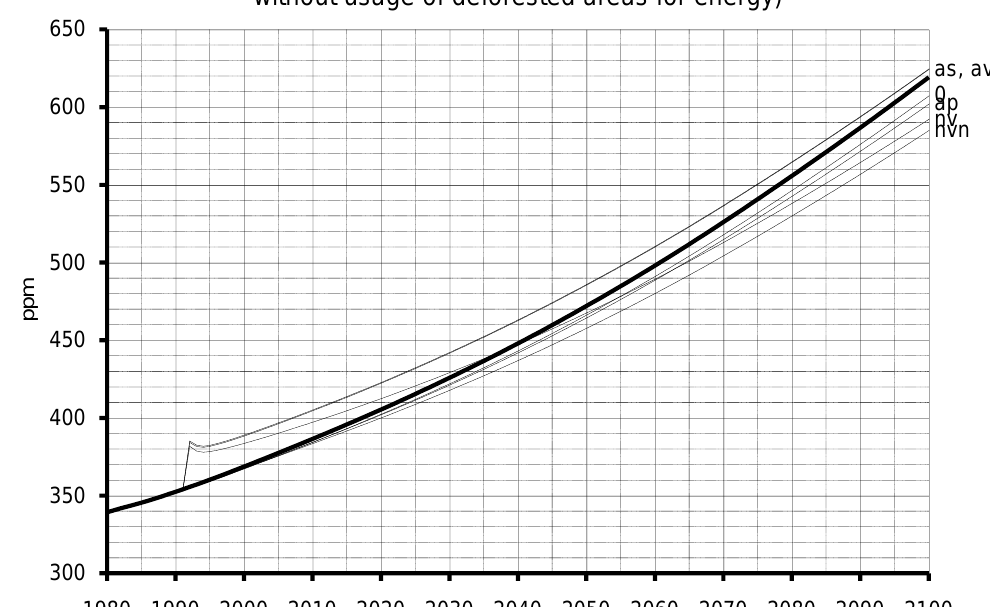
Figure 8. In a “+1%/a” CO 2 emission growth scenario, when dedicating 10% of areas for biomass production using all five described types of biomass scenarios ( without combustion of standing biomass for energy on possibly deforested areas), overall atmospheric concentrations remain much lower as compared to earlier “+3%/a” scenarios. A considerable effect on the atmospheric CO 2 concentration is exerted by those emissions that are generated by deforestation of areas for the targets of creating energy plantations. (While some decades ago this was still considered a highly unrealistic scenario, real developments disapproved of such an optimistic view.).